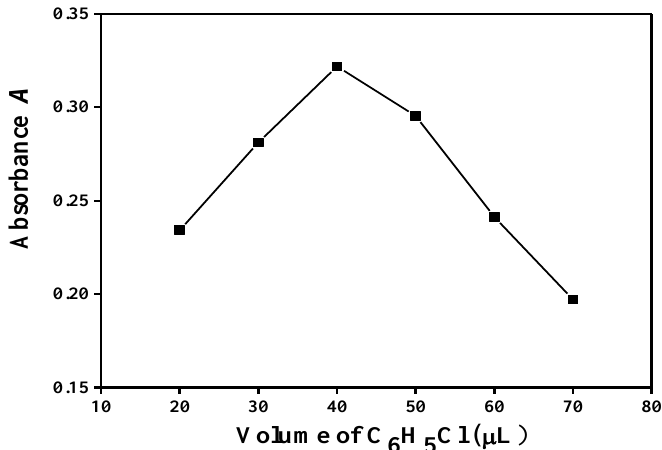
Figure 2. Effect of C 6 H 5 Cl volume on the extraction efficiency of Cu(II). Extraction conditions: 5.00 mL water sample, pH = 5.0, 100 µL 5 × 10 −4 mol/L 5-Br- PADMA, 500 µL CH 3 CN, and 0.5 ng Cu.